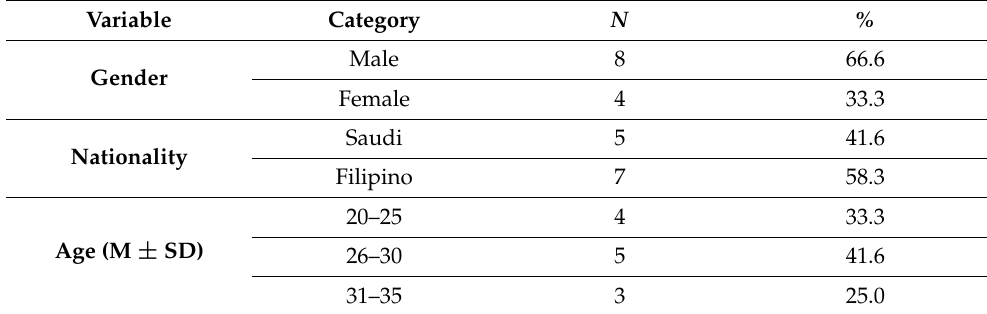
Table 2. Participant characteristics.